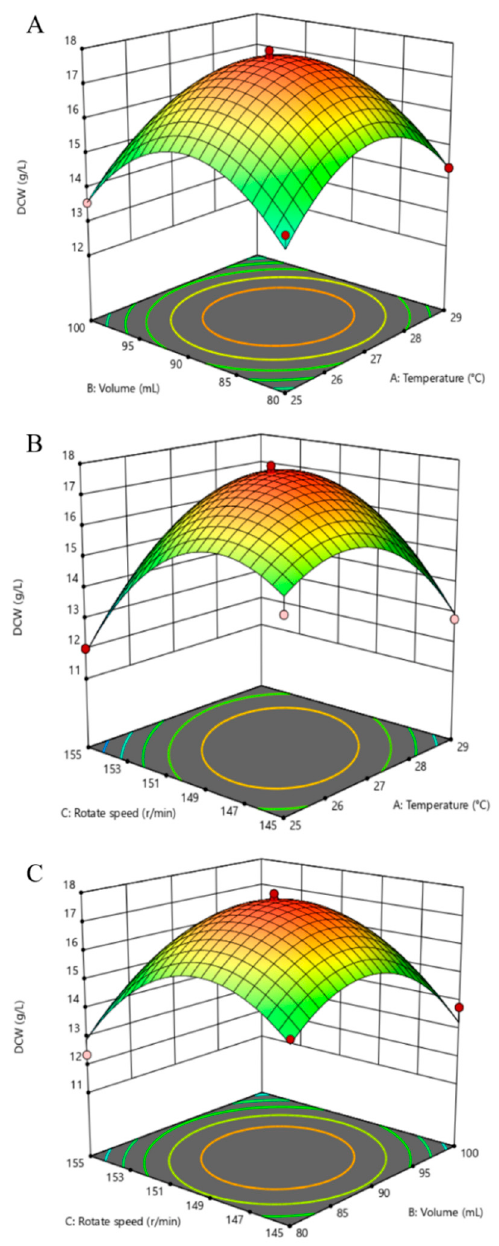
Figure 6. Response surface plot showing the effects of two various factors on the DCW of P. eryngii -3. ( A ) Combined effects on the DCW of temperature and volume; ( B ) Combined effects on the DCW of temperature and rotation speed; ( C ) Combined effects on the DCW of volume and rotation speed. Data points are the average of n = 3; error bars represent the standard error of the mean. The samples were harvested at 168 h of fermentation.